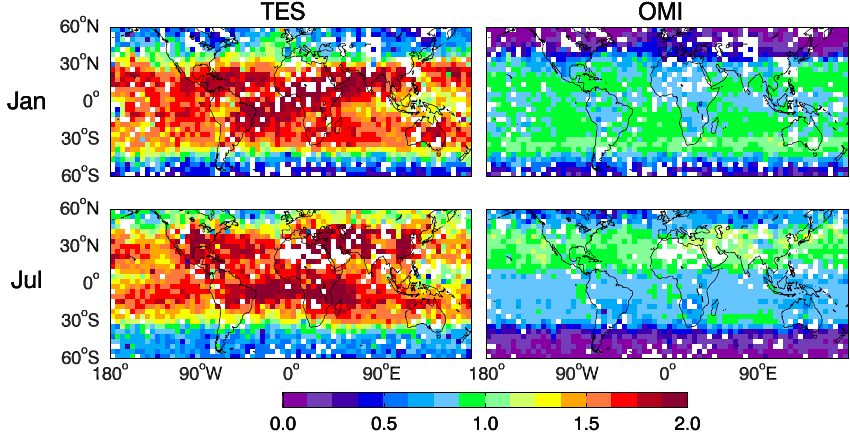
Fig. 2. Mean tropospheric DOFS for TES (left) and OMI (right) retrievals of tropospheric ozone in January (top) and July 2006 (bottom). The data are averaged on a 4 ◦ × 5 ◦ grid. Red colors indicate relatively high DOFS, and blue colors indicate relatively low DOFS. White areas indicate lack of data meeting the retrieval criteria described in the